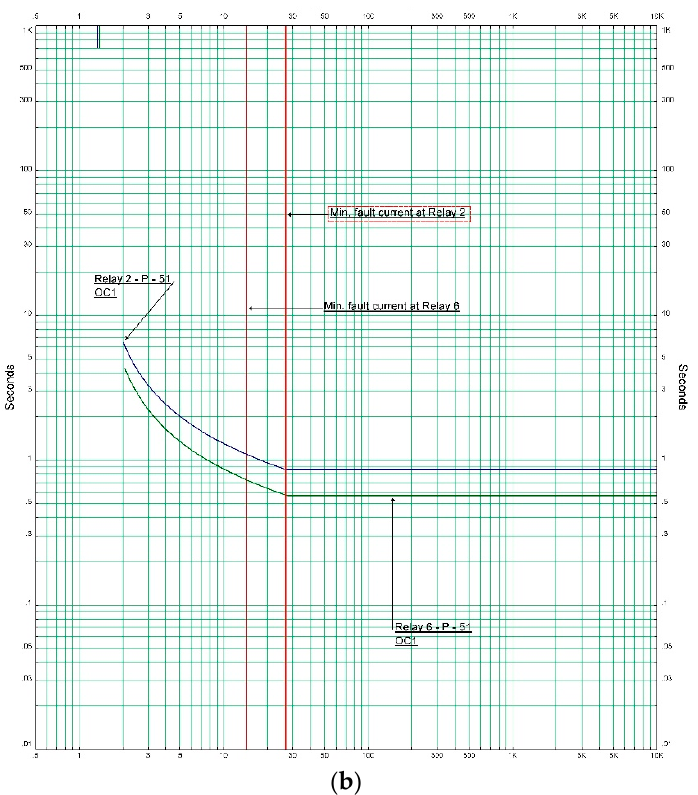
Figure 11. Time-current curves of relays 6 and 2 in case study 1 when applying: ( a ) The proposed algorithm, ( b ) The PSO algorithm.